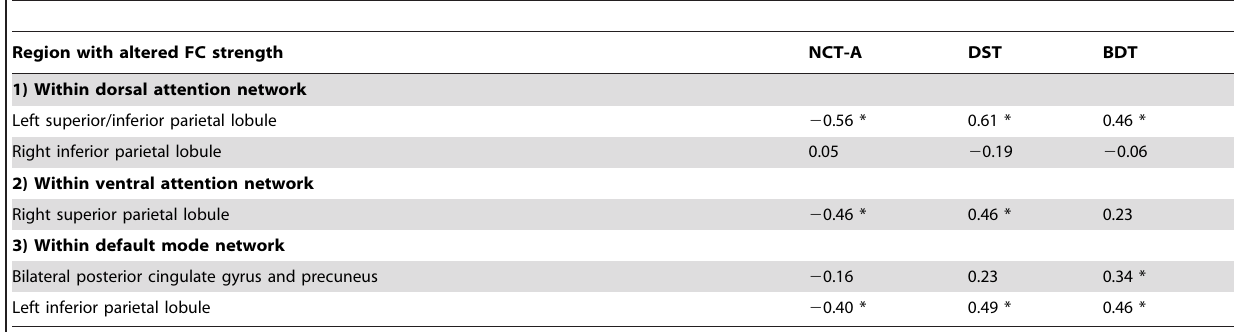
Table 3. Correlation between altered functional connectivity (FC) strength and psychometric results in cirrhotic patients.